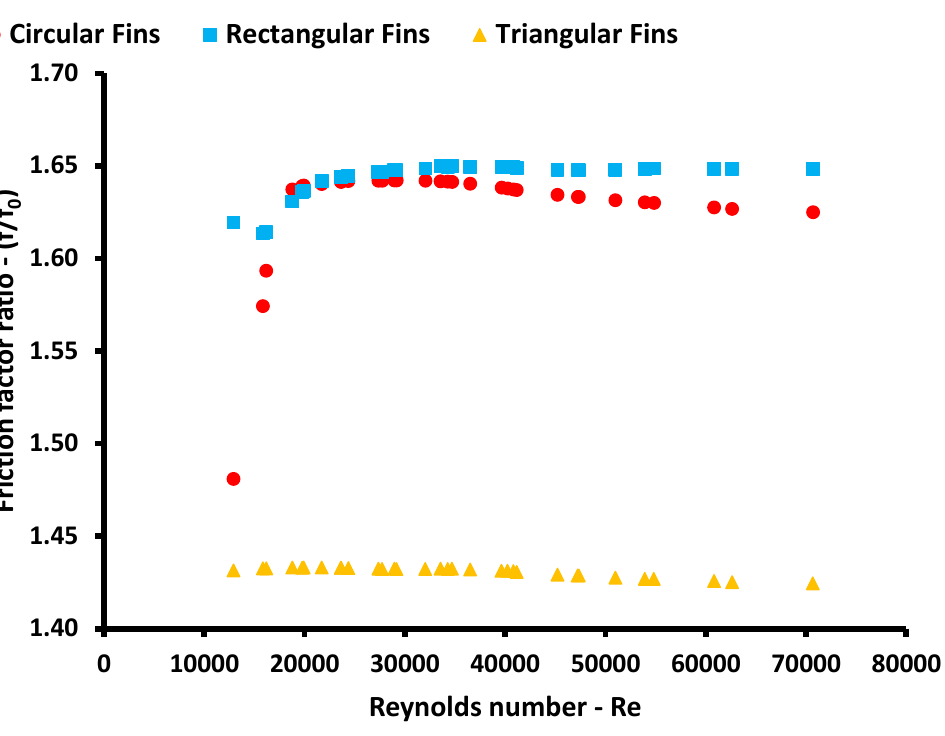
Figure 23. Nusselt number ratio in the different examined operating conditions for the different finned tubes.